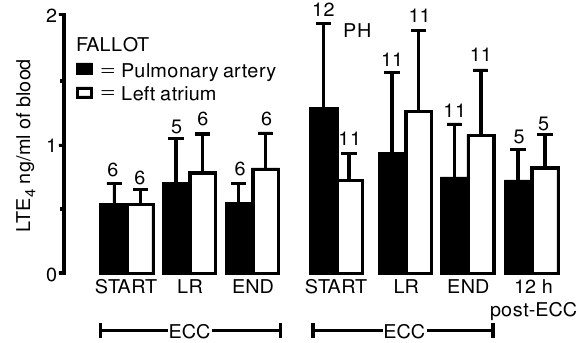
FIG. 1. Circulating leukotriene E 4 levels in infants during open heart surgery. Measurements of LTE 4 were performed in blood samples obtained during surgery in a group of infants without (Fallot) and with pulmonary hypertension (PH). Blood samples were derived from either the pulmon- ary artery or the left atrium at the beginning (START) of extracorporeal circulation (ECC), 5 min after lung reperfu- sion (LR) and at the END of ECC. In a limited number of subjects ( n = 5) measurements were made at 12 h post- ECC. Values are means SEM and the number of infants studied is presented above each